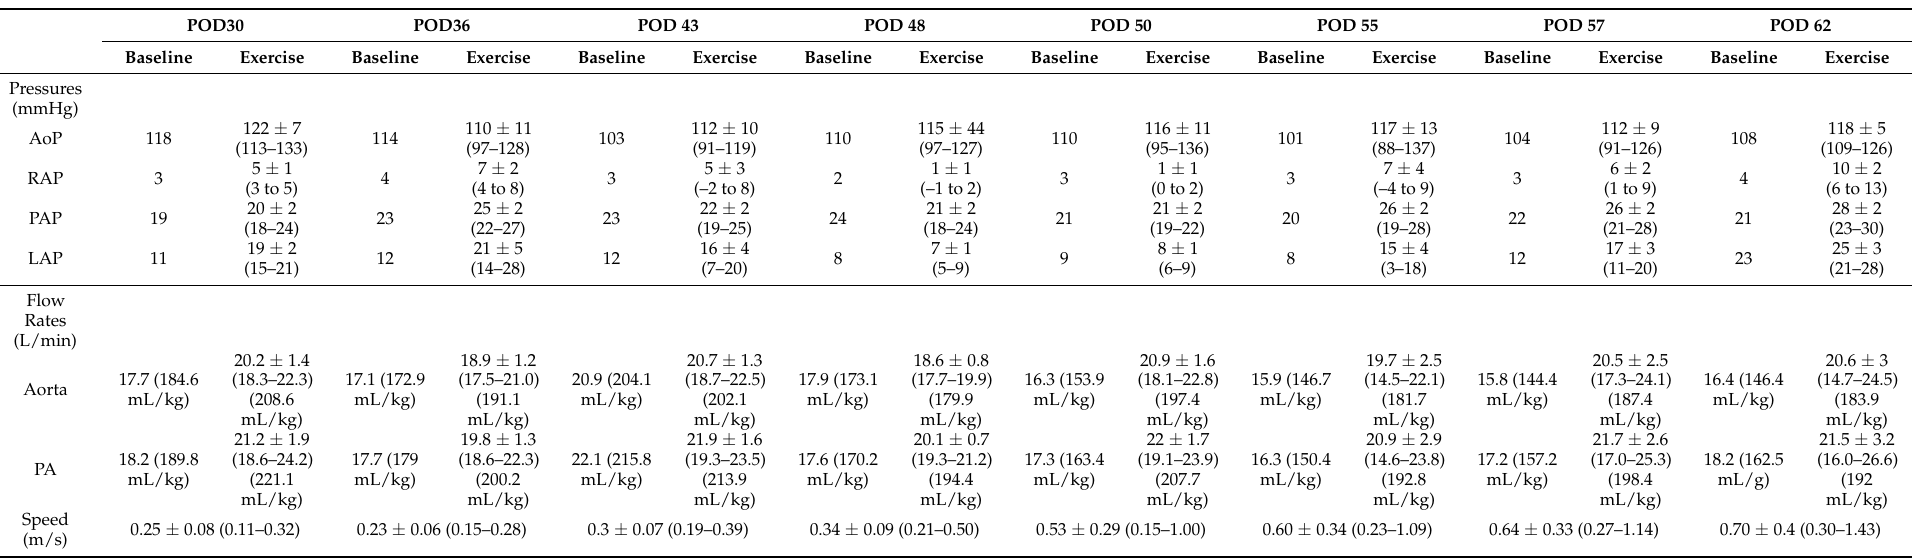
Table 2. Hemodynamic values at baseline and during treadmill exercise